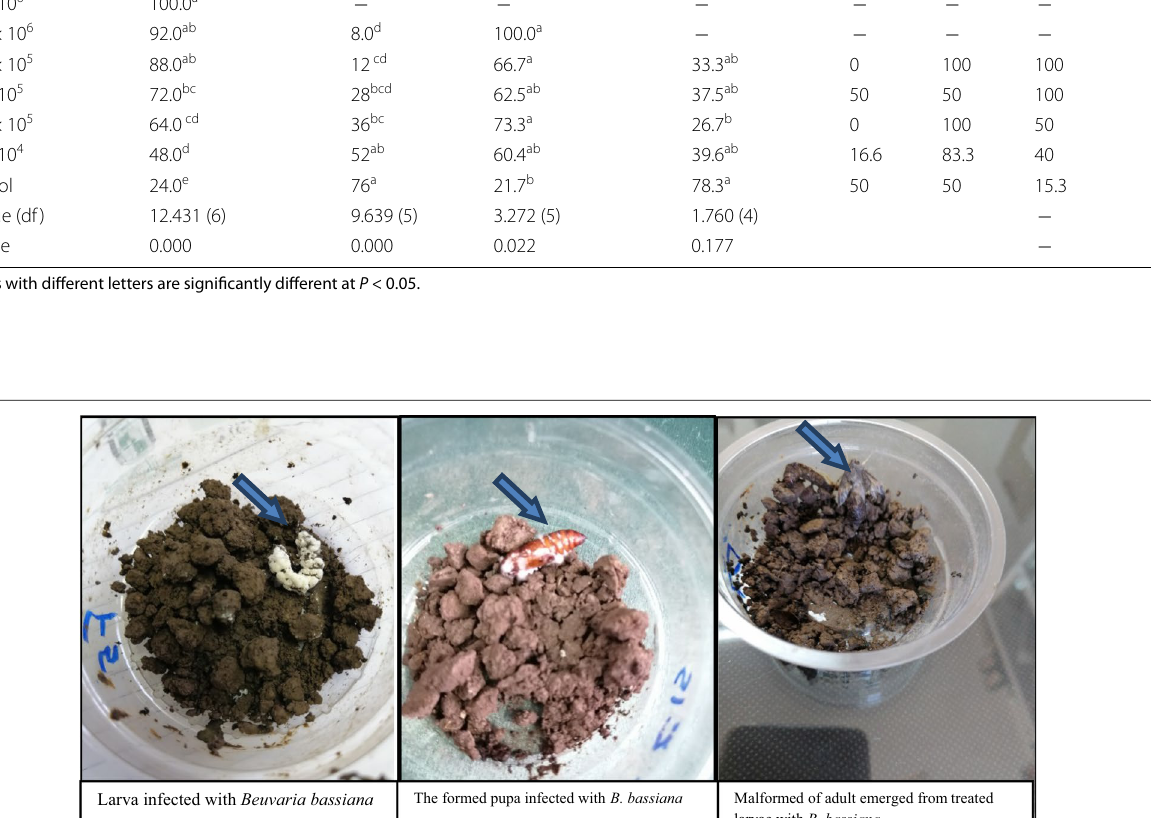
Means with different letters are significantly different at P < 0.05